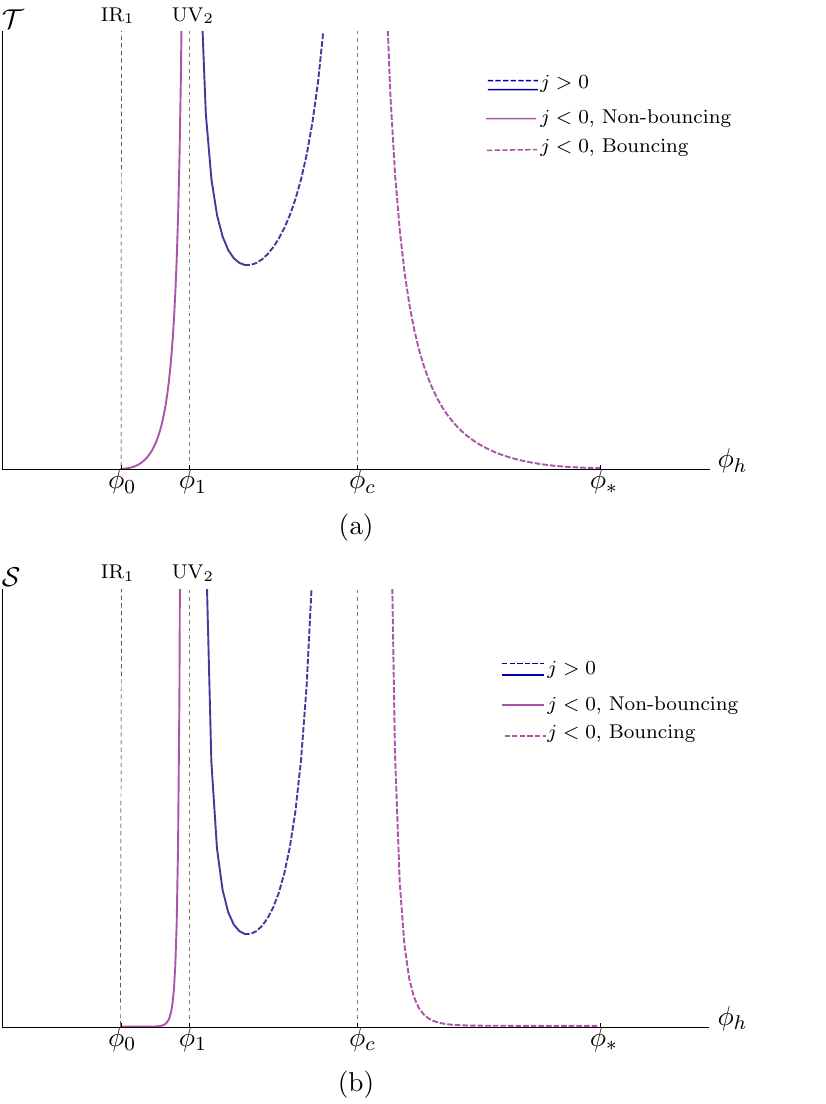
Figure 12 . The temperature (a) and entropy density (b) as a function of the scalar (cid:12)eld horizon value (cid:30) h for black holes connecting to UV 2 . The colours and dashes correspond to the (cid:13)ows shown in (cid:12)gure